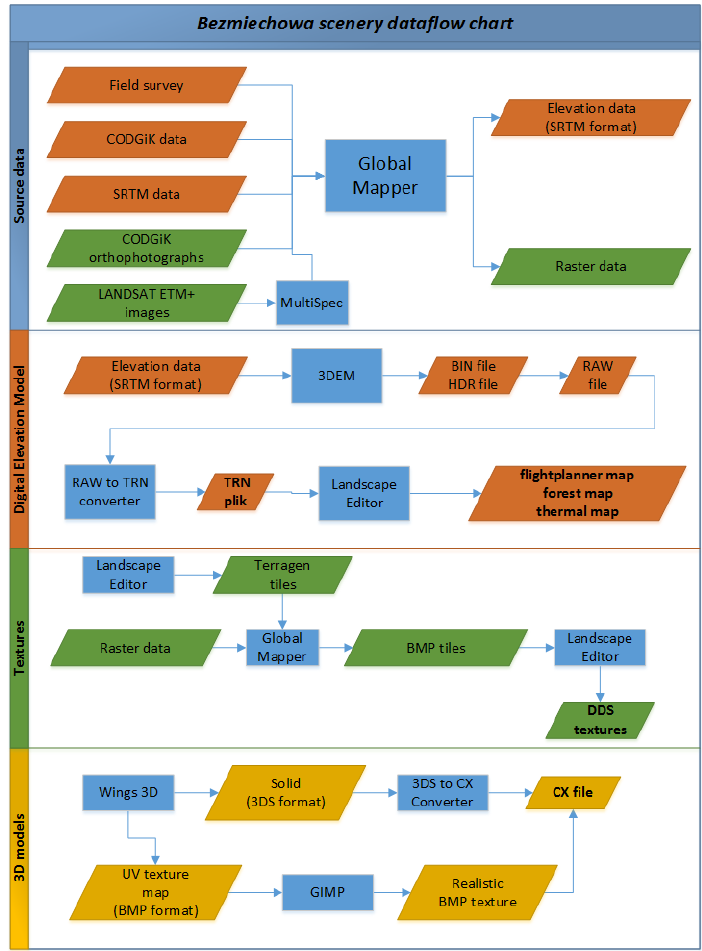
Fig. 9. Scheme of the process of Bezmiechowa scenery development (source: D. Chądzyńska